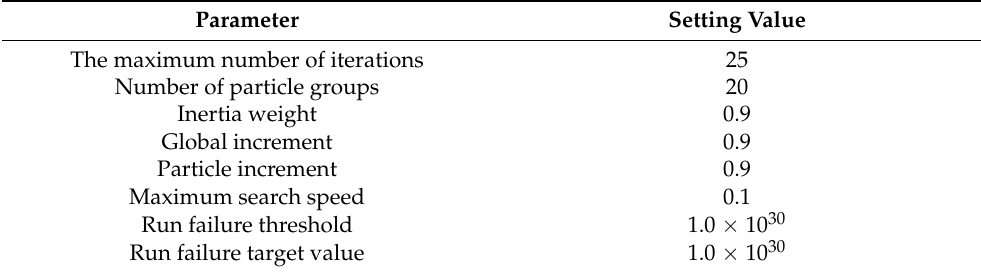
Table 1. Optimization algorithm settings.